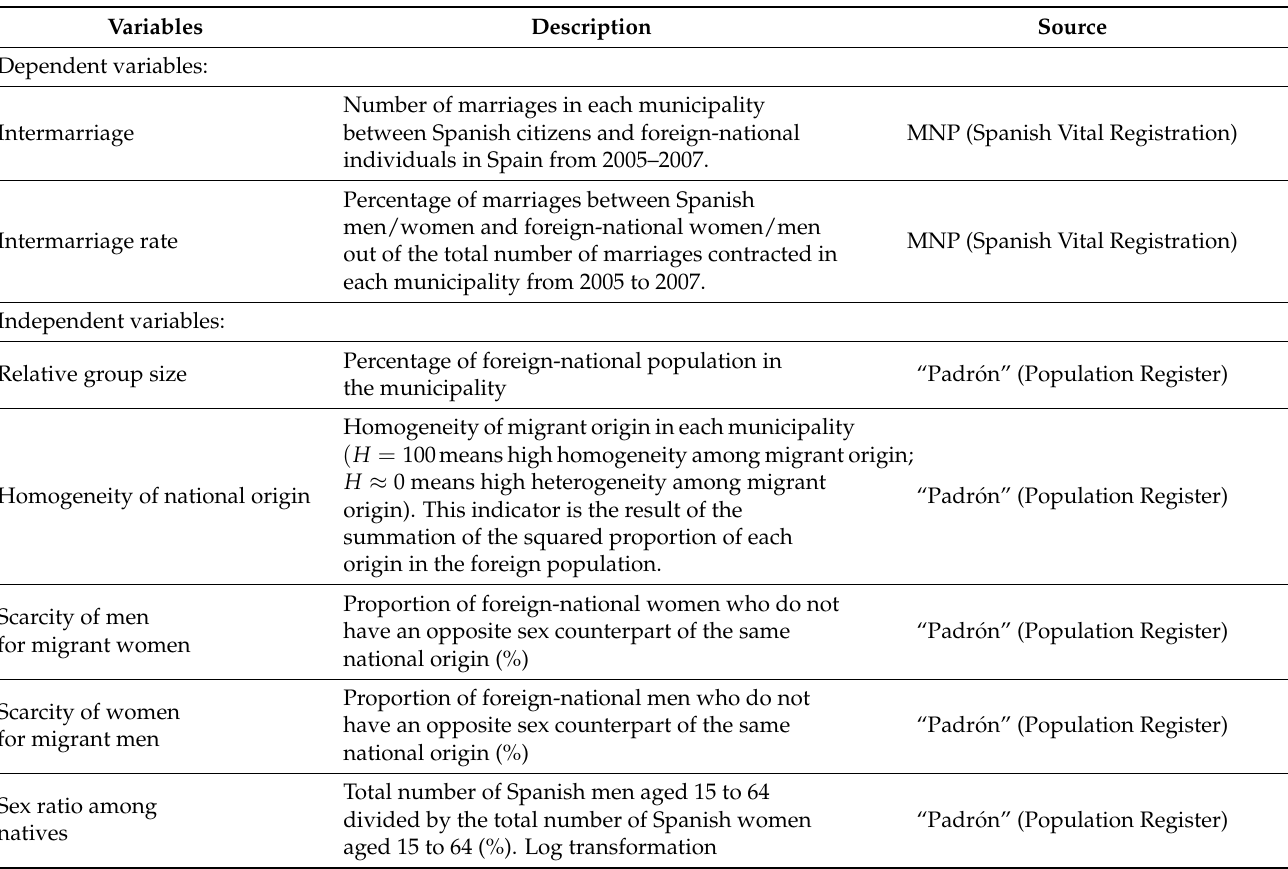
Table 1. Description and source of variables utilized in the